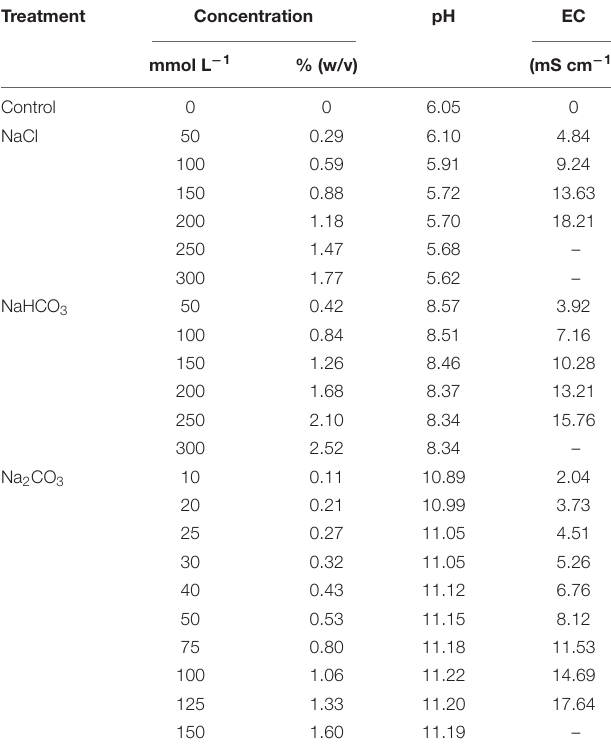
TABLE 1 | pH and electrical conductivity (EC) of NaCl, NaHCO 3 , and Na 2 CO 3 solution at the various concentrations.